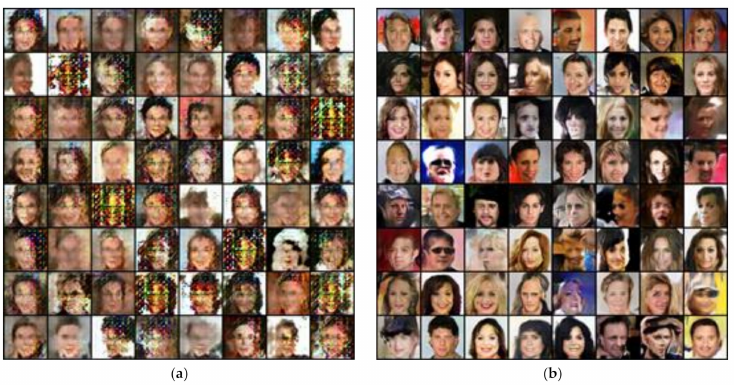
Figure 6. The samples generated by different models. ( a ) 600 iterations without SN, ( b ) 600 iterations with